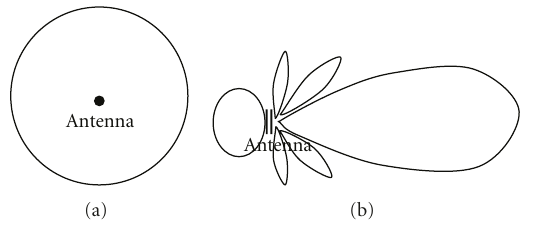
Figure 1: Transmission region of omnidirectional antenna and directional antenna.